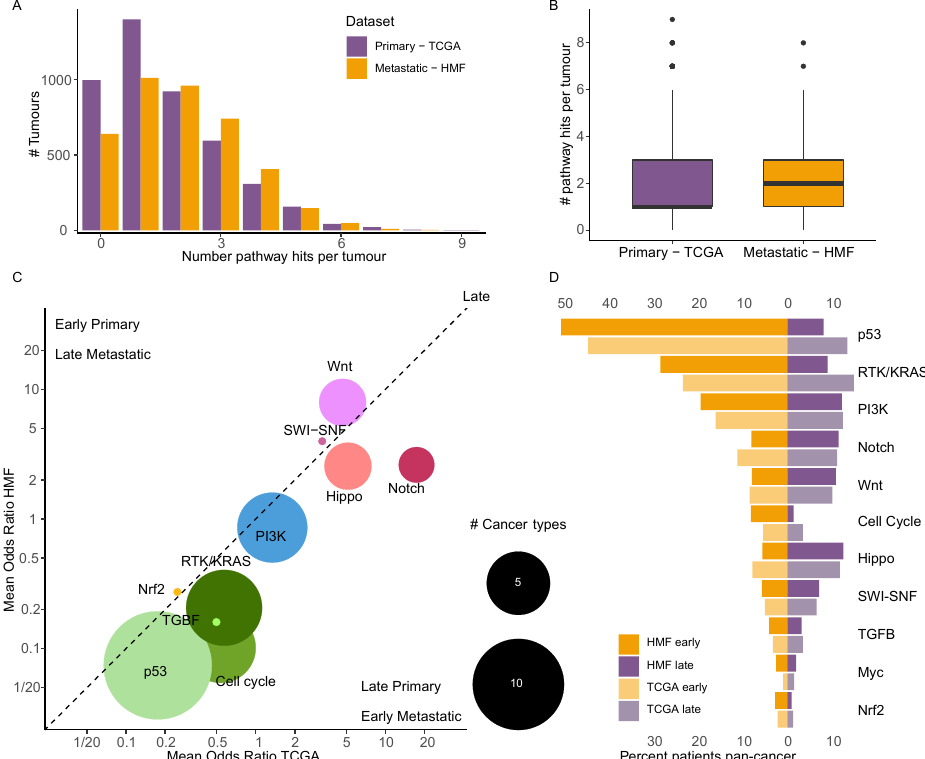
Figure 4. Enriched timed pathways. ( A ) Histogram showing the number of affected cancer pathways by driver mutations. ( B ) Boxplot showing the number of affected specific cancer pathways in primary and metastatic cancer. ( C ) A bubble plot of the mean odds ratio for enrichment of early or late pathway hits in primary vs. metastatic cancer. The size of the bubble shows the number of significant cancer types. ( D ) A mirror plot showing the percentage of patients pan-cancer which have been affected by early and late driver mutations in each of the 11 cancer specific pathways.